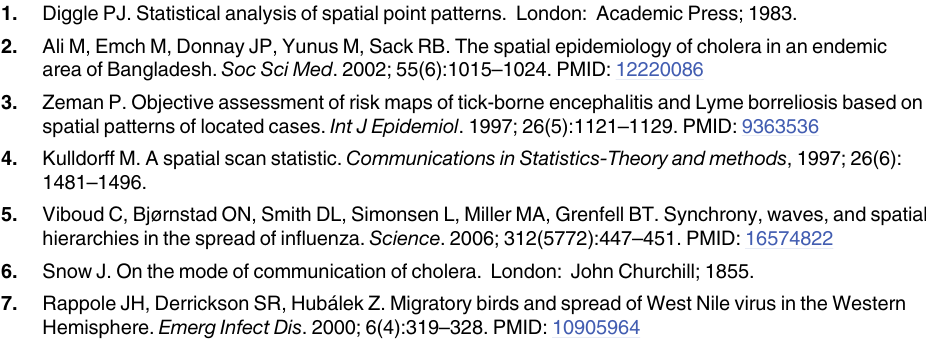
, d ) 1 2 , 1 , d ) using loca- 1 2